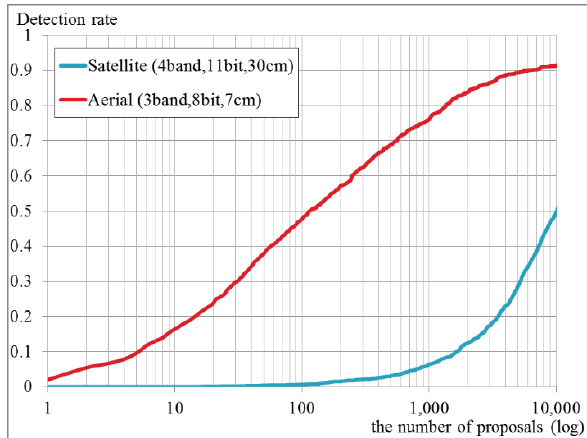
Figure 7. Comparison of detection rate between different image bands and bit